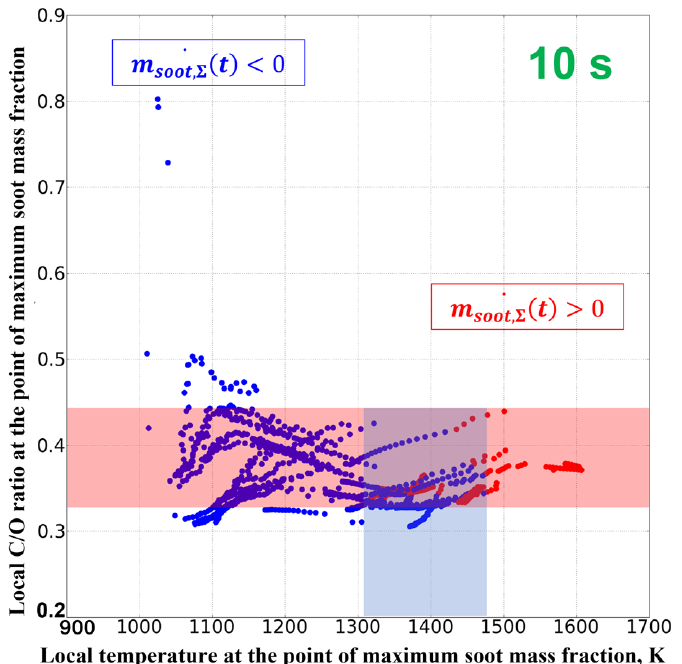
Figure 10. Calculated dependences of the cumulative rate of soot formation 𝑚 (cid:3046)(cid:3042)(cid:3042)(cid:3047),(cid:2954) (𝑡)(cid:4662) on the C/O atomic ratio and temperature at the point of maximum soot concentration in the flame structure at different times after ignition: ( a ) 2 s; ( b ) 5 s; ( c ) 10 s; red dots: 𝑚 (cid:3046)(cid:3042)(cid:3042)(cid:3047),(cid:2954) (𝑡)(cid:4662) > 0, and blue dots: 𝑚 (cid:3046)(cid:3042)(cid:3042)(cid:3047),(cid:2954) (𝑡)(cid:4662) < 0.